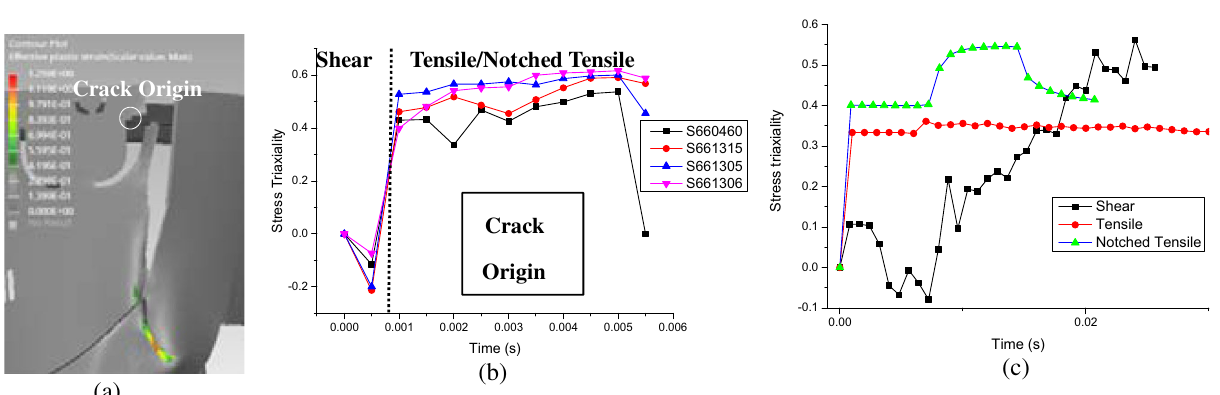
Figure 16. ( a ) Diagram showing the location of the eroded elements taken for crack origin, ( b ) corresponding stress triaxiality curves of the crack origin and ( c ) stress triaxiality curves of crack origins of individual tests of shear, tensile and notched tensile